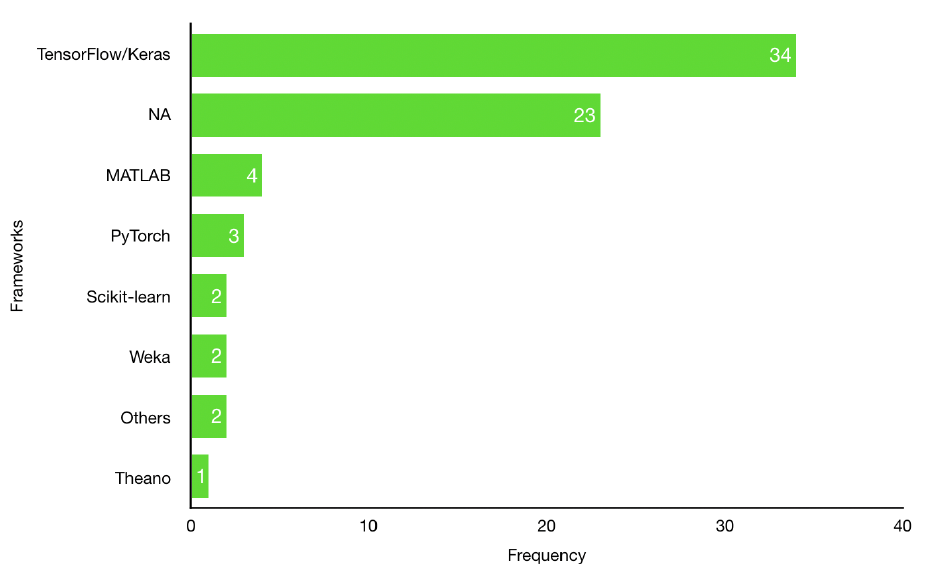
Figure 10. Histogram of frameworks and platforms used in selected